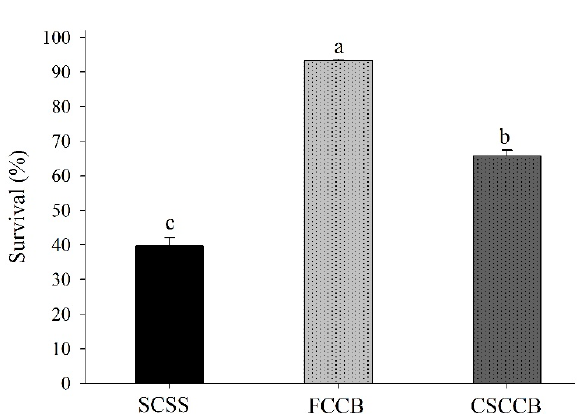
Figure 2. Survival (%) of L. paracasei LBC 81 in the suspension of cells in saline solution (SCSS), fermented chickpea and coconut beverage (FCCB), and cell suspension in chickpea and coconut beverage (CSCCB), after exposure to ( A ) simulated gastric juice, ( B ) simulated pancreatic juice, and ( C ) sequential exposure to gastric and pancreatic juice. Different lowercase letters differ significantly by the Tukey test at 5% probability. n = three repetitions.